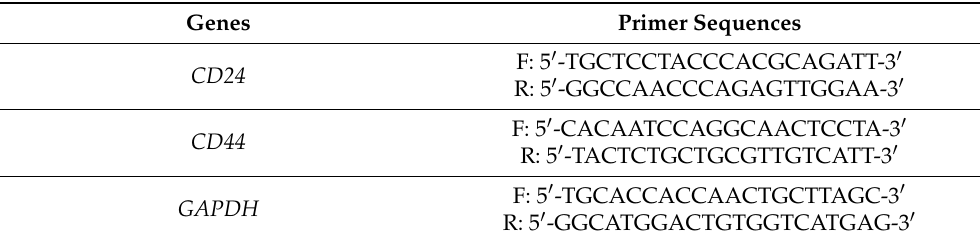
Table 3. Primer sequences used for real-timepolymerase chain reaction (PCR) analysis.